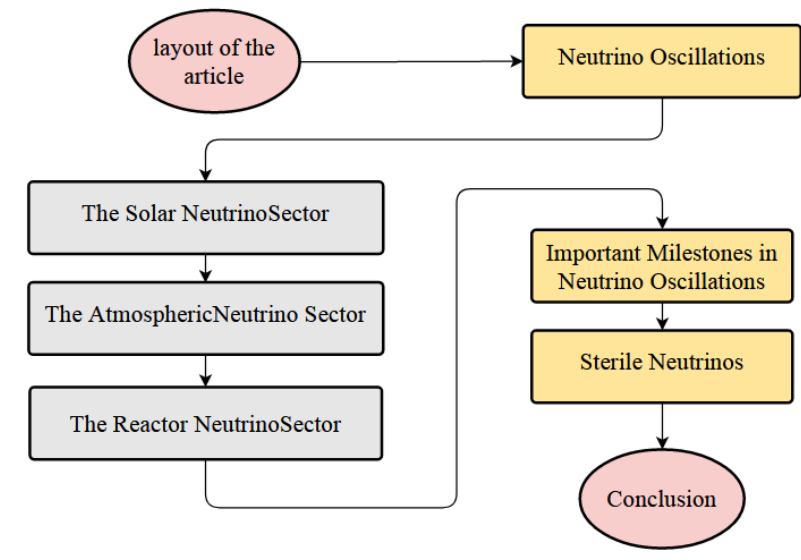
Figure 1. Flowchart of the research